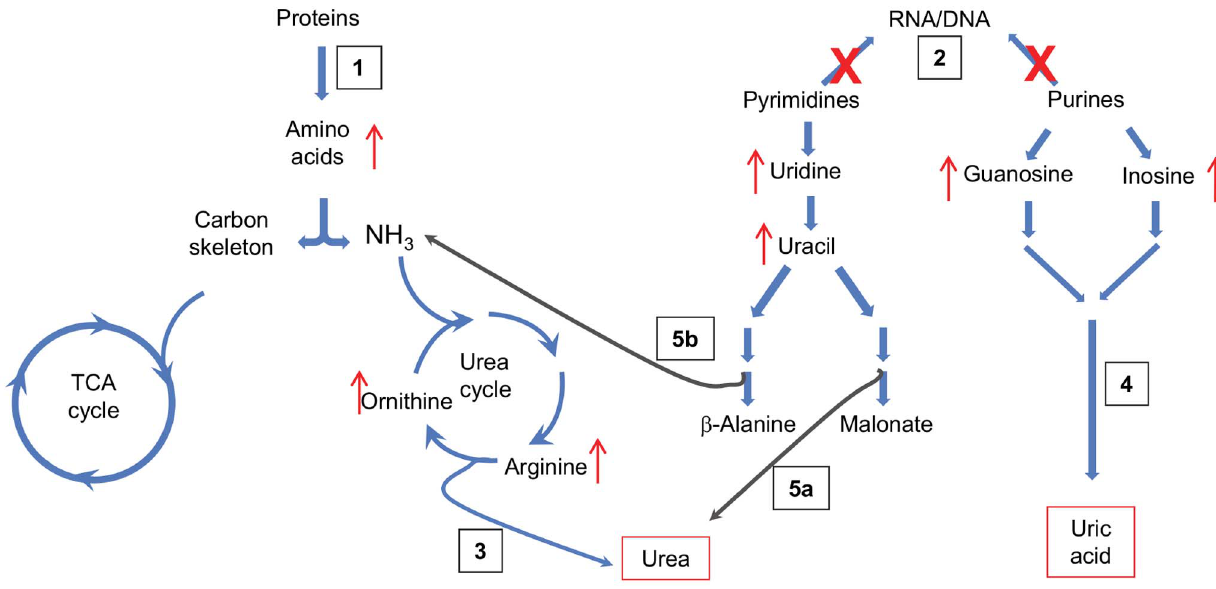
Figure 3. Affected biochemical pathways. Schematic depiction of the biochemical pathways L. vannamei may use to avoid NH 3 toxicity during the TAN spike in the nursery phase. Blue arrows indicate normal metabolism pathways, red symbols indicate interrupted pathways or increasing concentrations due to the TAN spike, gray arrows denote pathways of microbial origin. (1) Increase in protein catabolism; (2) Inhibition of RNA and DNA synthesis; (3) Urea excretion through the OUC; (4) Uric acid excretion by purine catabolism; (5) Urea excretions by (a) pyrimidine oxidation and/ or (b) pyrimidine reduction. GD 41) and the shrimp collected to the end of the growout (GD 48– GD 118; Figure 4B and 4C, Table S3(c–d)). SDS calculations (Figure 4C top, FAST minus FAST pre ) had metabolomes generally lower in most amino acids (BCAAs, proline, alanine, serine, asparagine, glutamine, histidine, aspartate, glutamate, phenylalanine, and tyrosine), the organic acid lactate, uridine, and the carbohydrates maltose, glucose, glucose-1-phosphate and trehalose, and had higher levels of glycine, arginine, inosine, carnitine, and ADP/ATP. Similar metabolic changes were identified in the SDS comparing post-fasted shrimp to fasted shrimp (Figure 4C middle, FAST post minus FAST). The metab- olite level changes shown in Table S3(c) suggest that energy metabolism was affected and basically the shrimp were in starvation mode. The overall decrease in carbohydrates indicated fuel sources were low and the decrease of nearly all amino acids suggest catabolism of these glucogenic compounds to generate glucose via gluconeogenesis because the exogenous and/or endogenous sources had become insufficient (Table S3(c)). The decreased levels of lactate also indicate contribution to the gluconeogenic supply of glucose for energy needs. Although ADP and ATP are indistinguishable in the shrimp muscle spectra, the increase in ADP would corroborate gluconeogenic activity, while the increase in ATP may be produced from the reduced carbon skeletons of amino acids shuttled through the tricarboxylic acid (TCA) cycle and oxidative phosphorylation pathways.